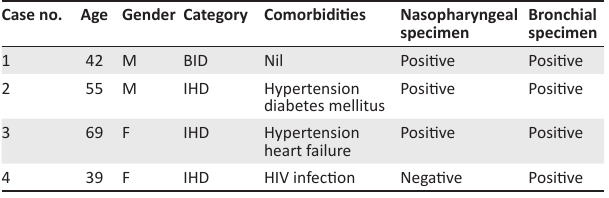
TABLE 2: Summary of SARS-CoV-2 induced deaths during post-mortem at the 37 Military Hospital, Accra, Ghana, May